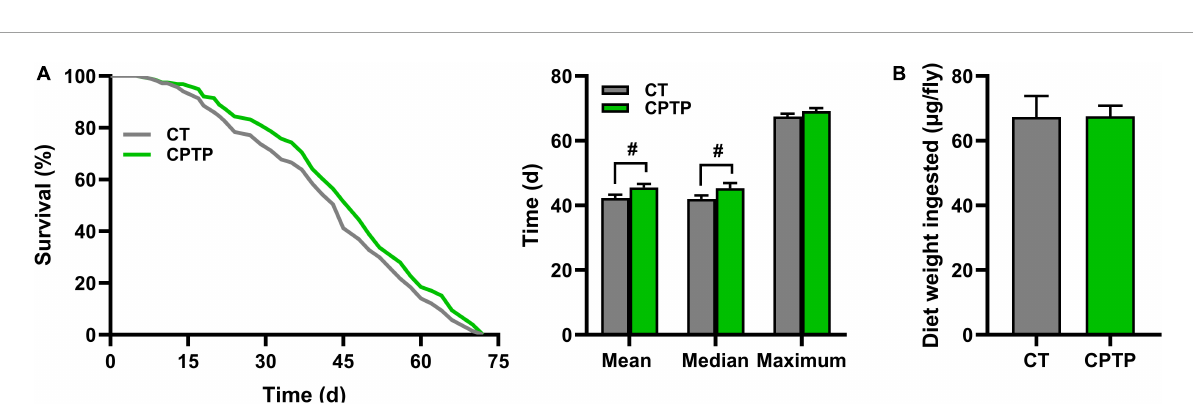
FIGURE2 Chinese pond turtle peptide (CPTP) extended life span without changing food intake in female flies. (A) Life span curves, n = 300–350 flies per group; (B) Food intake, n = 300–350 flies per group. The data are presented as mean ± SEM. Statistical test: two-tailed unpaired t -test [ # P < 0.05 vs. control group (CT)